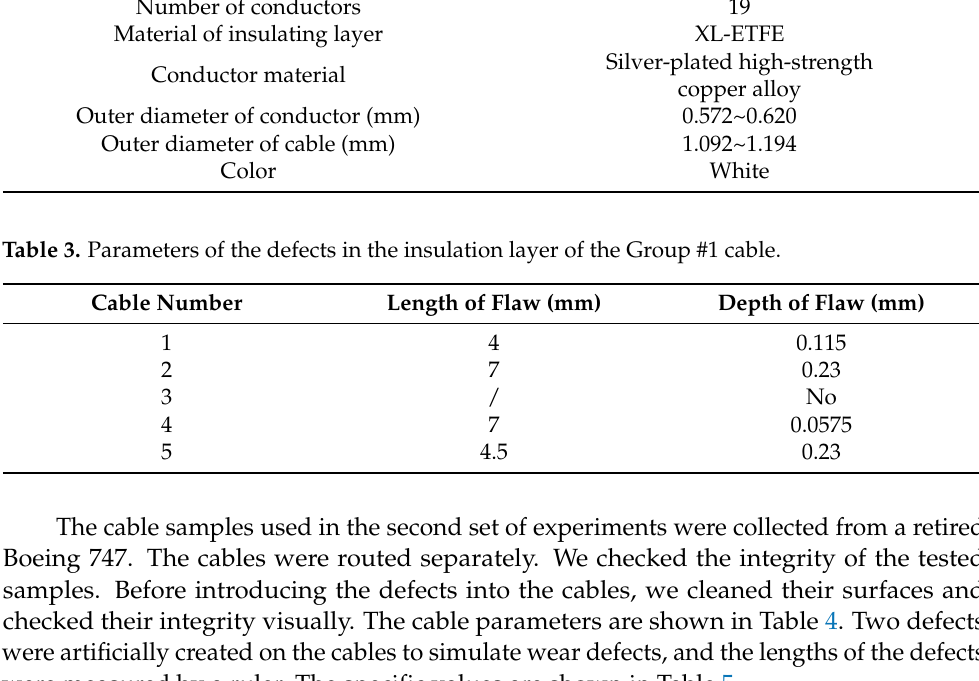
Table 2. Parameters of the Group #1 tested cable.